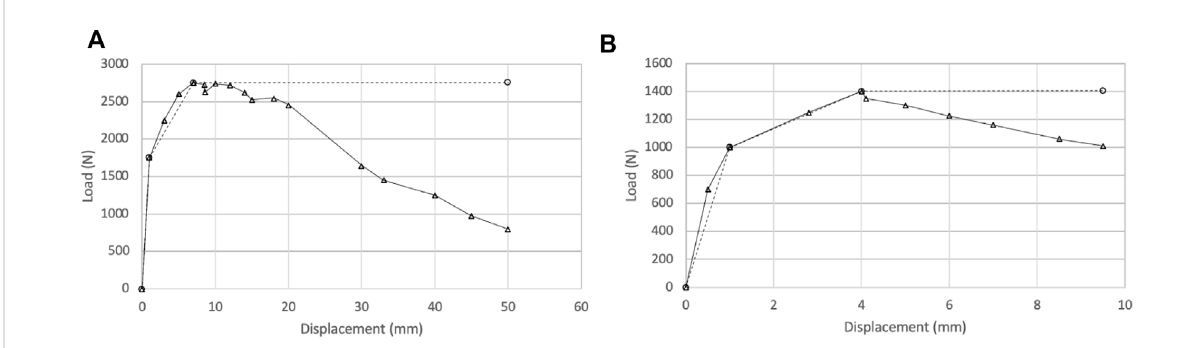
FIGURE 5 Load-deformation curves taken from test data [Riley and Sadek, (2003)] △ , plotted alongside load-deformation curves of the same de fi ned connections from post-analysis ○ : (A) RTWC Axial; (B) RTWC Lateral Shear.